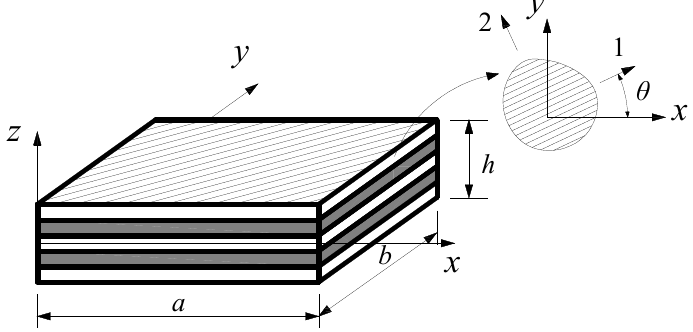
Figure 1. Schematic representation of a composite laminate. Each single-layer of the laminate is usually assumed to be in the plane-stress state. As shown in Figure 2, σ 1 and σ 2 are the normal stress components in the principle direc- tions of the single-layer, and τ 12 represents the shear stress component. The